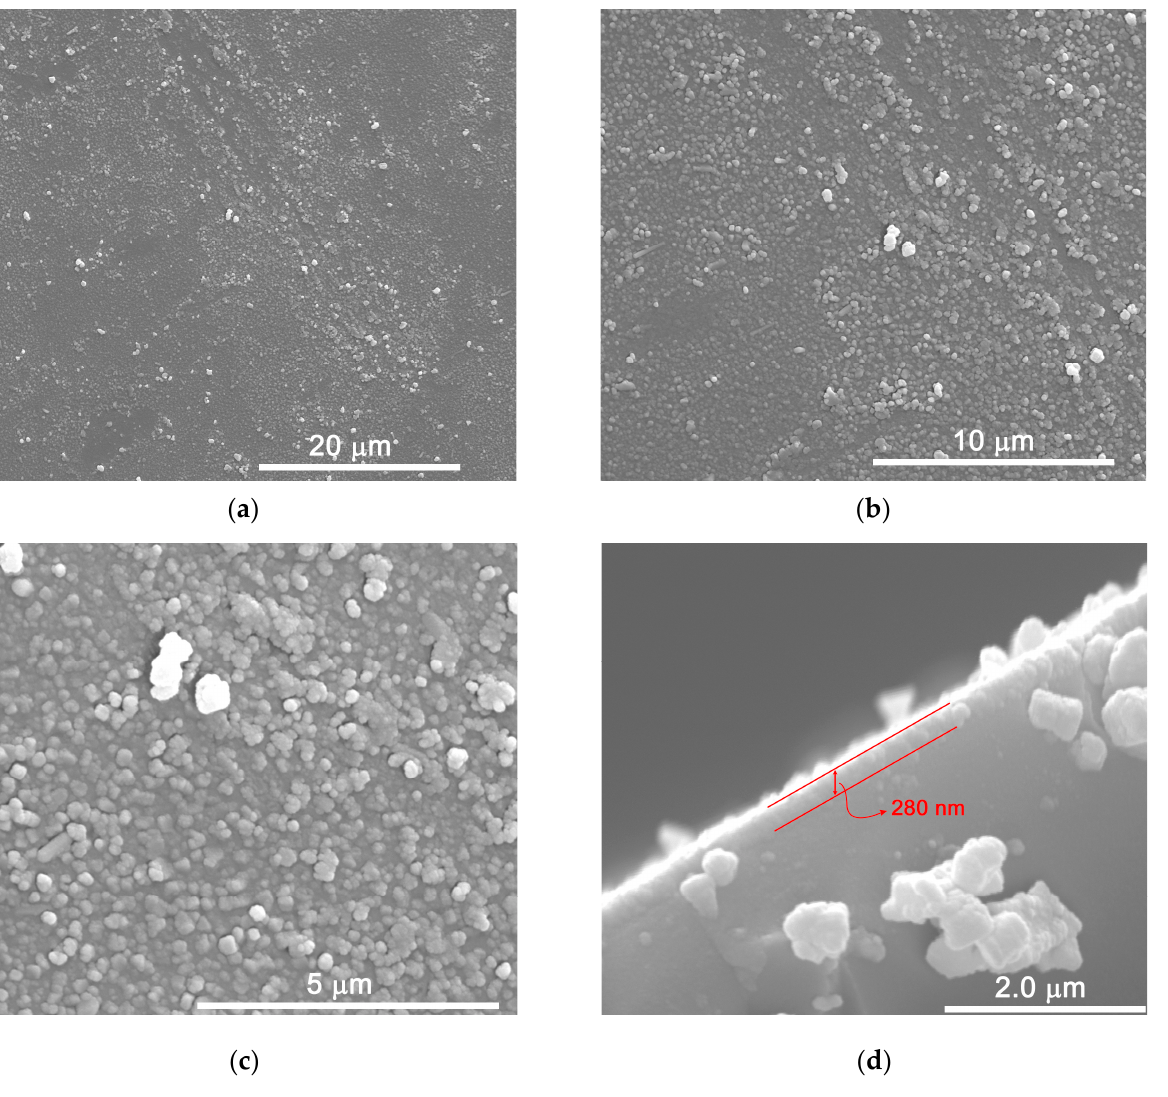
Figure 2. Scanning electron microscopy images for the iron vanadate sample obtained by the successive ionic adsorption and reaction process. The images were acquired using a magnification of ( a ) 5000×, ( b ) 12,000×, ( c ) 30,000×, and ( d ) 50,000×. The image ( d ) was obtained by the cross-section, with the average thickness of the electrode with five layers.